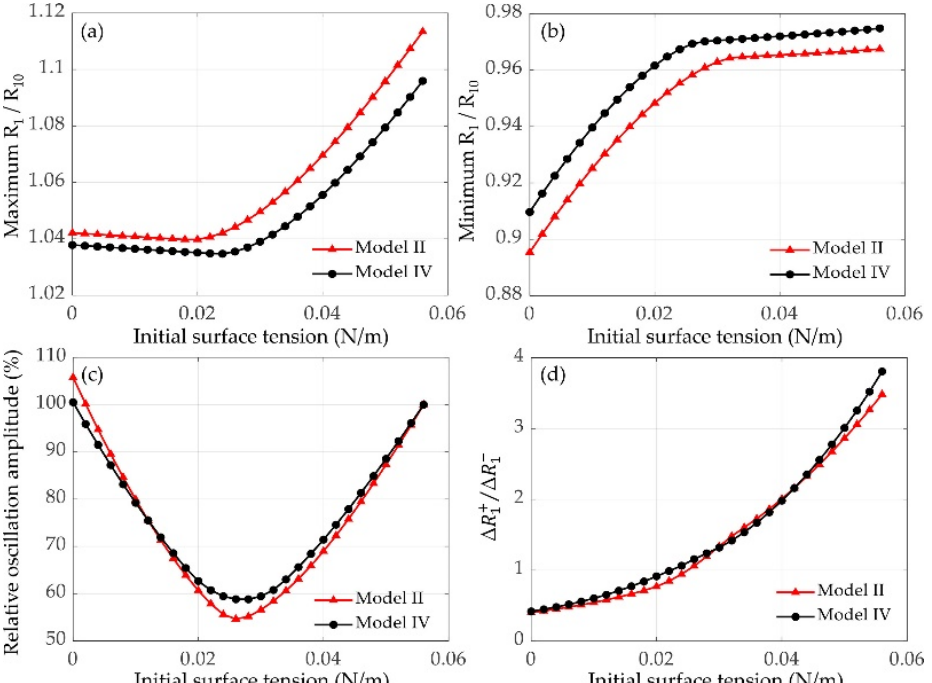
Figure 4. ( a ) Maximum and ( b ) minimum normalized radii of the small bubble ( R 1 / R 10 ) in two lipid-coated microbubbles without (model II) and with (model IV) bubble–bubble interactions as a function of initial surface tension σ 0 ( P A = 100 kPa, d i,j = 20 µ m). ( c ) The relative oscillation amplitudes of lipid-coated bubbles with different σ 0 to the uncoated bubble with σ 0 = 0.056 N/m. ( d ) The ratios of the positive and negative radius excursions ∆𝑅 (cid:2878) ∆𝑅 (cid:2879) ⁄ as a function of initial surface tension.